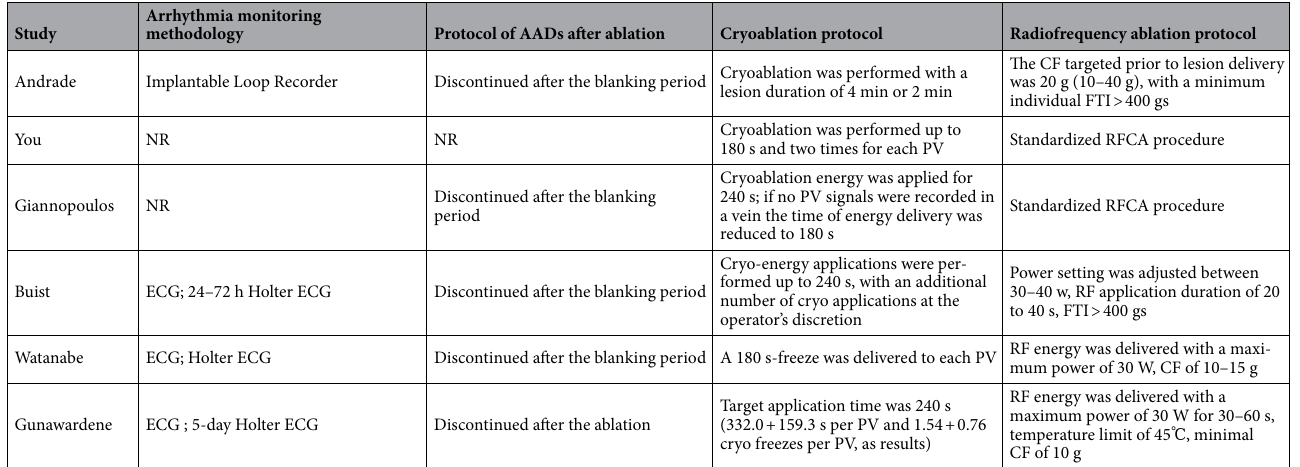
Table 2. Procedural and monitoring protocols of the included studies. AADs = antiarrhythmic drugs, ECG = electrocardiograph, PV = pulmonary vein, CF = contact force, FTI = force–time integral, RFCA = radiofrequency catheter ablation, NR = not